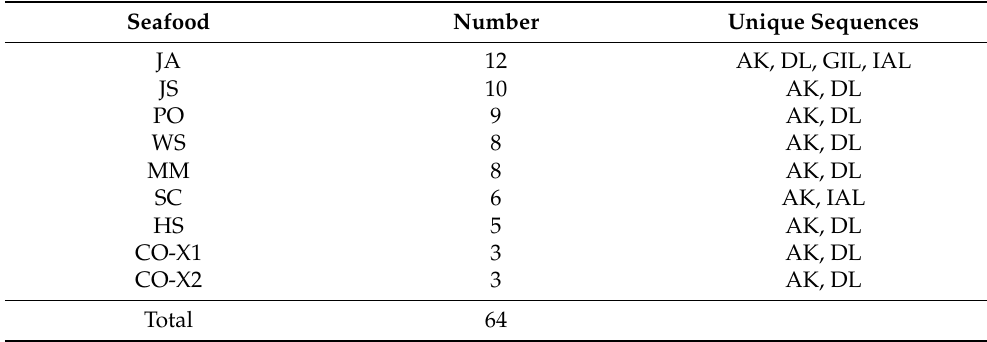
Table 3. The numbers of high-GI-absorption, non-allergenic, and non-toxic peptides without known anti-ACE and anti-DPP-IV activities.